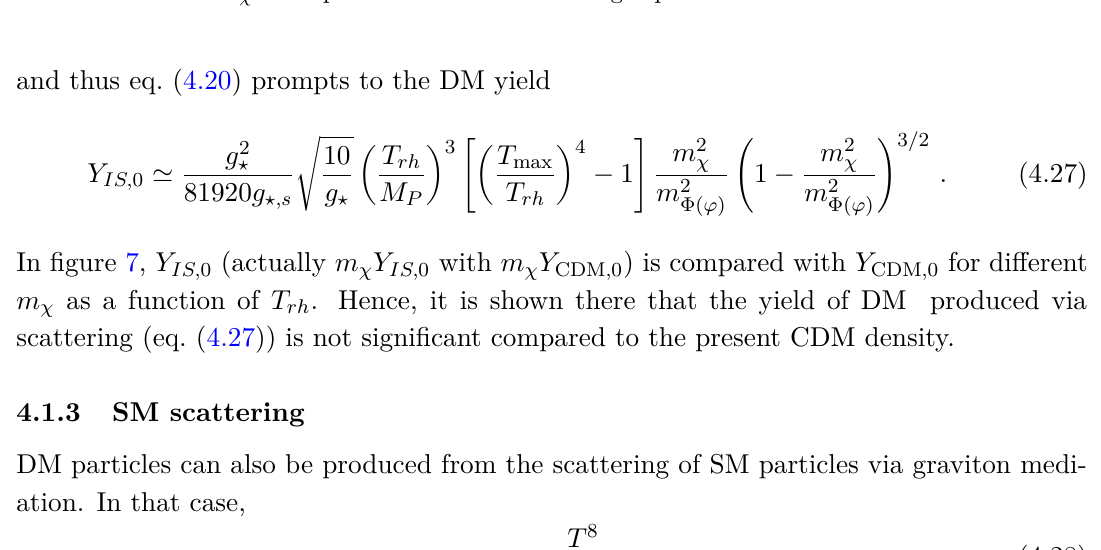
Figure 7. m χ × Yield of DM produced from the 2-to-2 scattering with graviton as mediator for different values of m . Left panel is for Model I and right panel for Model II χ